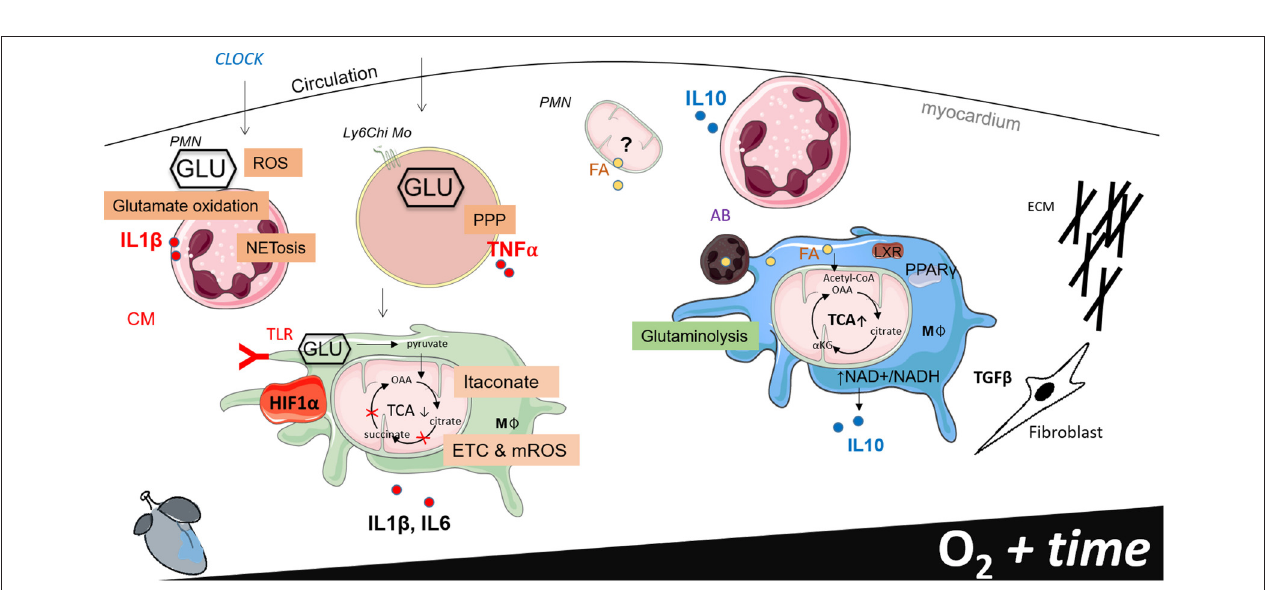
FIGURE 2 | Working model of phagocyte immunometabolism after myocardial infarction (MI). This figure separates cardiac inflammation based on time (the first week post MI) and oxygen saturation within the infarct border zone. Little information is known about the functional metabolic capacity of macrophage CCR2 and MHCII resident and recruited subsets in the heart, therefore generalizations are made to classify macrophages according to metabolic phenotype.